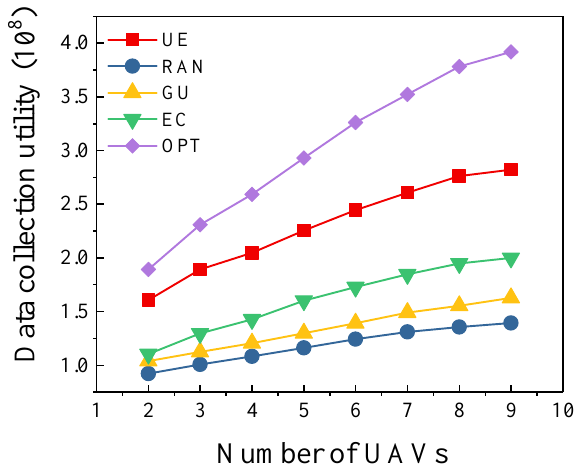
Figure 4. Different Numberof UAVs.